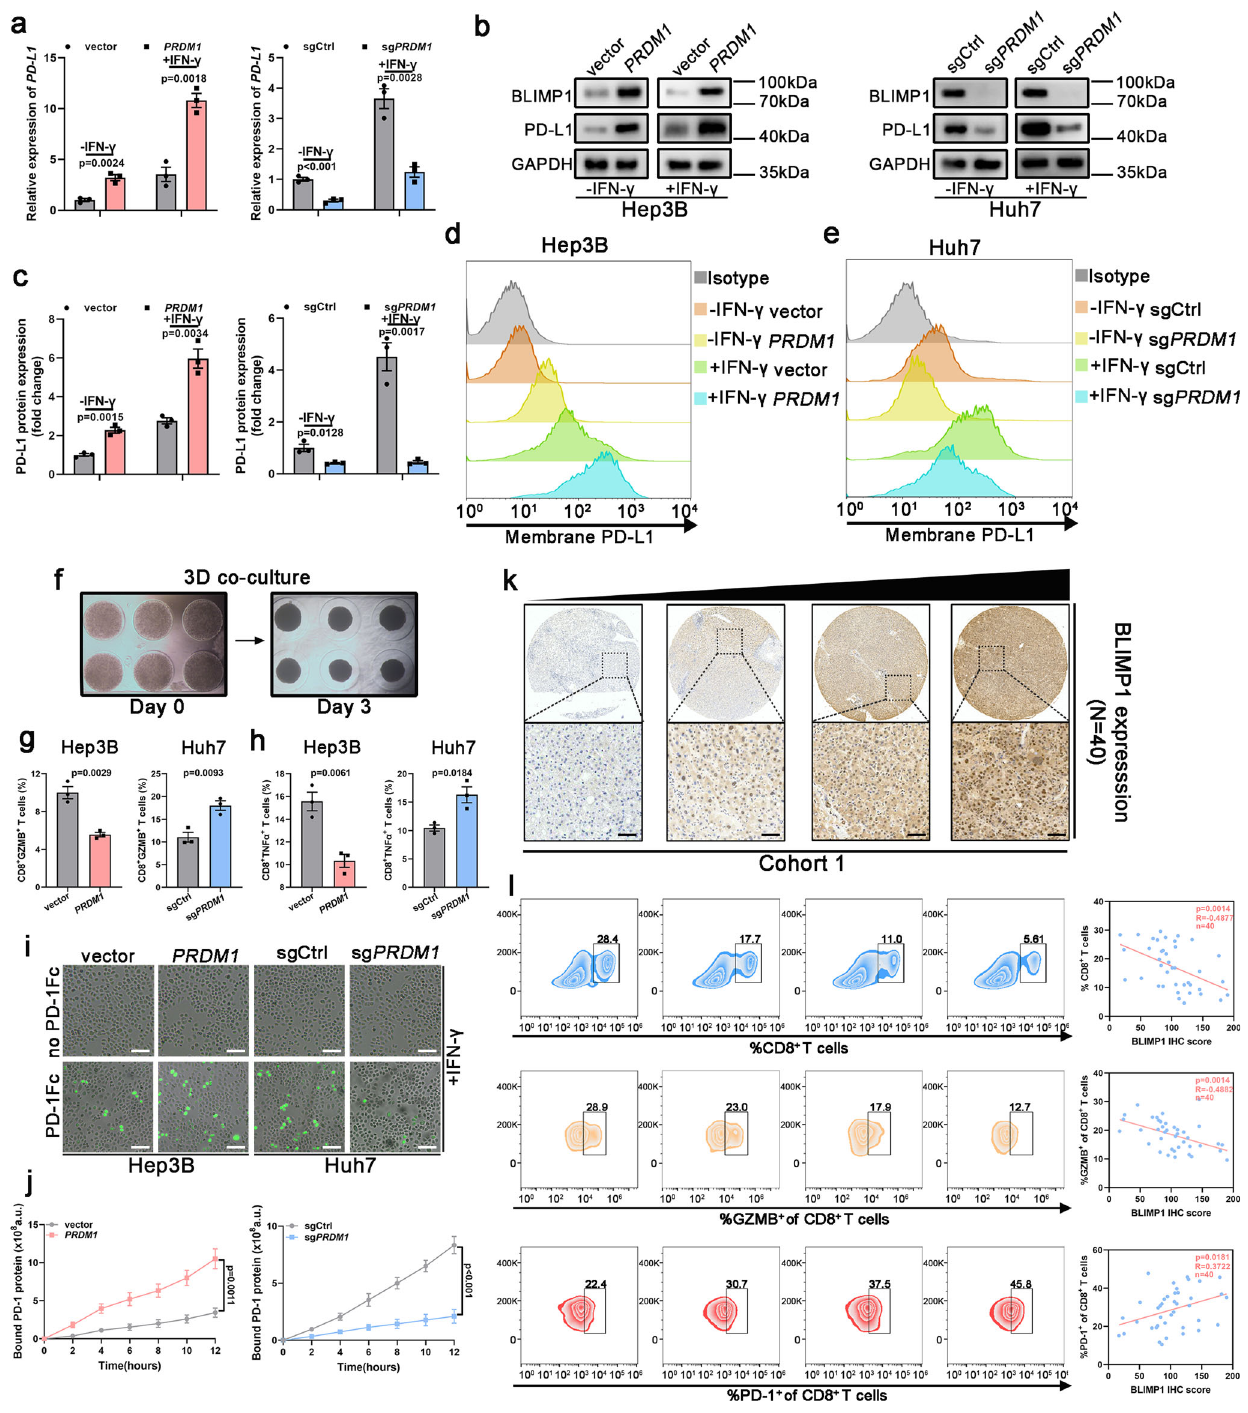
Fig. 1 | PRDM1 upregulates PD-L1 expression in HCC. a qRT-PCR of PD-L1 expression in Hep3B cells or Huh7 cells with or without IFN- γ treatment. Data presented as mean±SEM ( n =3 independent biological replicates). b , c Western blotting of PD-L1 expression in Hep3B cells or Huh7 cells with or without IFN- γ treatment. Representative of n =3 independent biological replicates. d , e Flow cytometry analysis of PD-L1 expression in Hep3B cells ( d ) or Huh7 cells ( e ) with or without IFN- γ treatment. n =3 independent biological replicates. f 3D-co-culture model using pre-activated T cells and Hep3B or Huh7 cells. g Flow cytometry analysis of CD8 + GZMB + cell content in pre-activated T cells following 72h of co- culture with Hep3B or Huh7 cells. Data presented as mean±SEM ( n =3 indepen- dent biological replicates). h Flow cytometryanalysisof CD8 + TNF α + cellcontent in pre-activated T cells following 72hours of co-culture with Hep3B or Huh7 cells. Data presented as mean±SEM ( n =3 independent biological replicates). i Time-